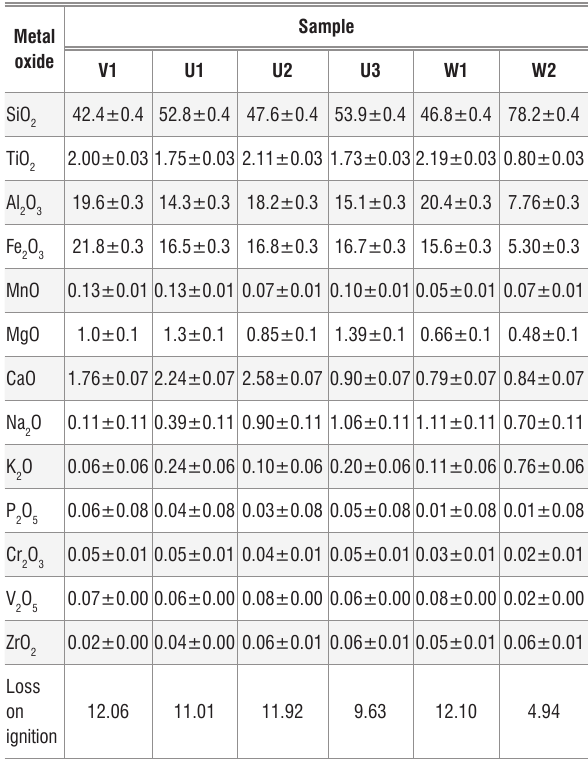
Metal oxide content (wt%) determined by X-ray fluorescence spectroscopy and loss on ignition results